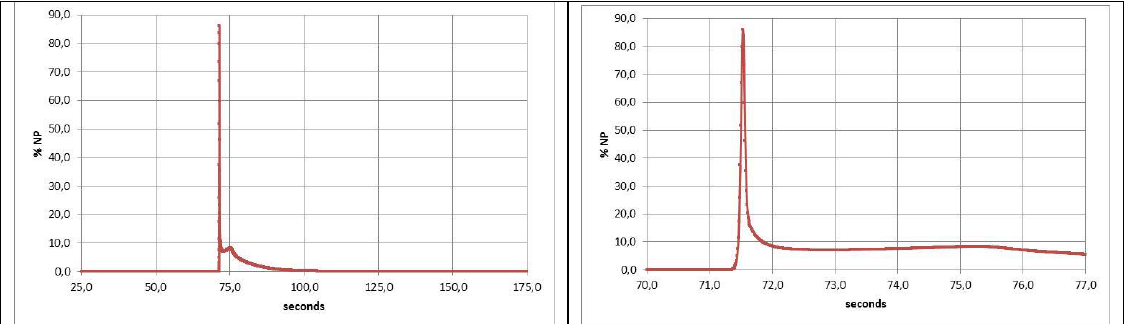
Figure 3 : Inhomogeneous Dilution – Core Power (complete and zoom)